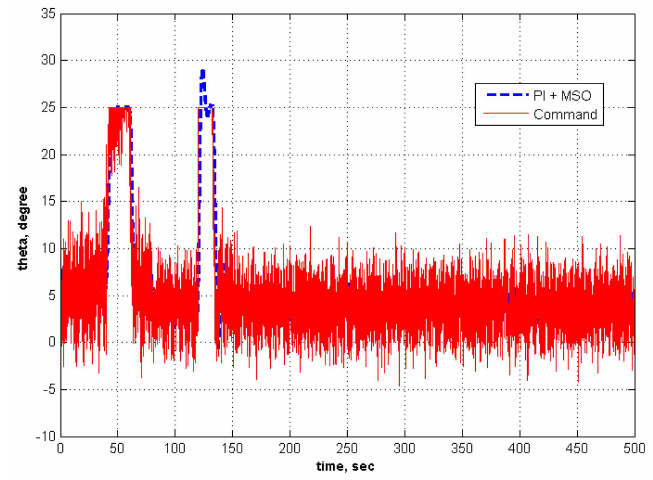
Figure 12. Pitch angle response for 50% C m α in an aircraft.